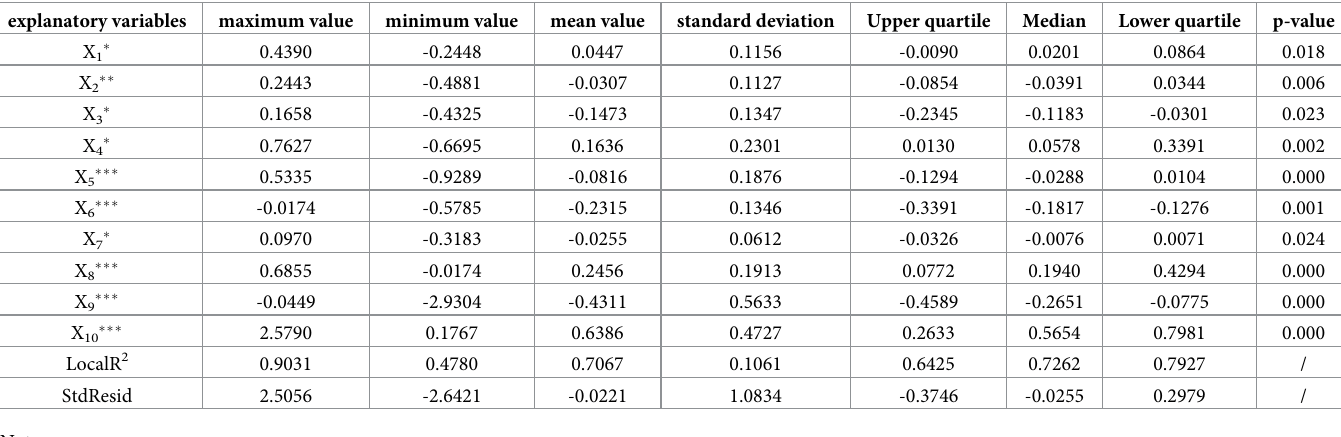
Table 6. GWR model regression coefficient